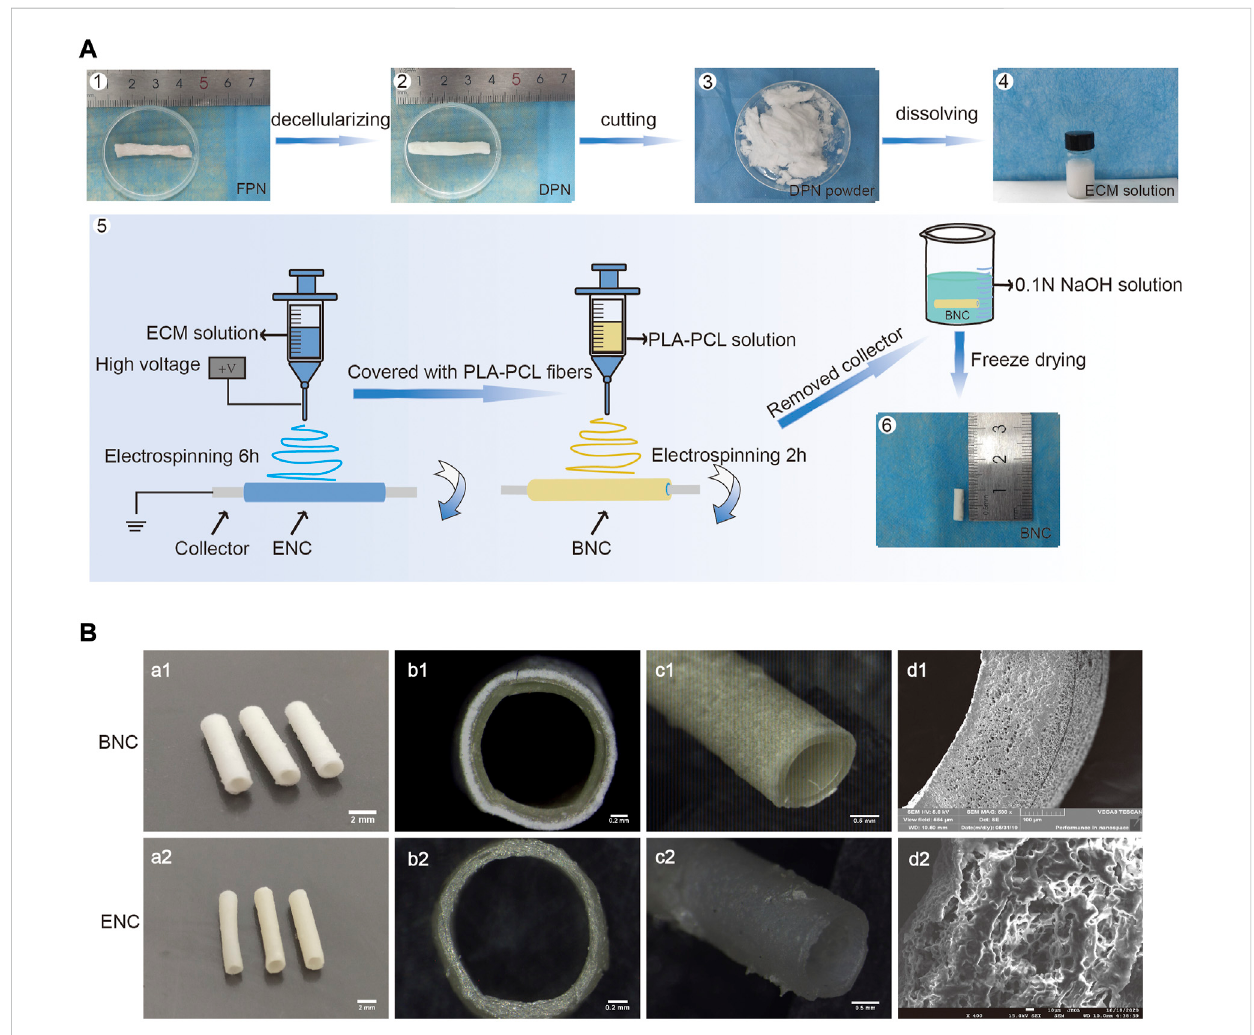
FIGURE 1 The fabrication ofBNC. (A) The procedure ofmanufacturing BNC.i.e., brie fl y,thefresh porcine sciatic nerves(FPNs) werethoroughlydecellularized toDPNs,cutintoslices,lyophilizedtopowders,completelydissolvedintotheECMsolution,andlastlyprocessedtoBNCbyelectrospun. (B) TheSEMand the stereoscope images of BNC and